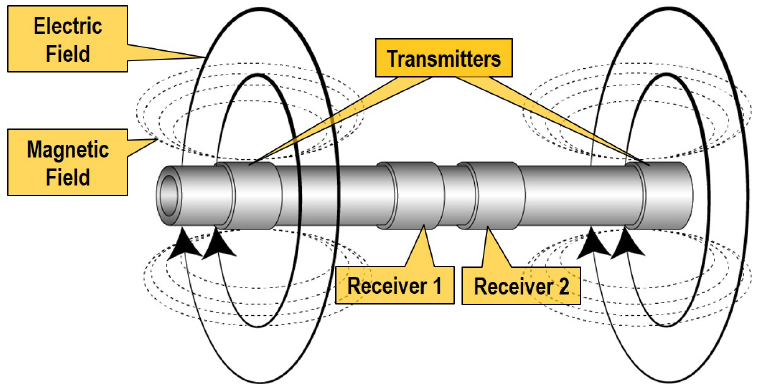
Figure 8. Schematic diagram of receivers’ and transmitters’ placement in the resistivity tool. Based on the invention described in